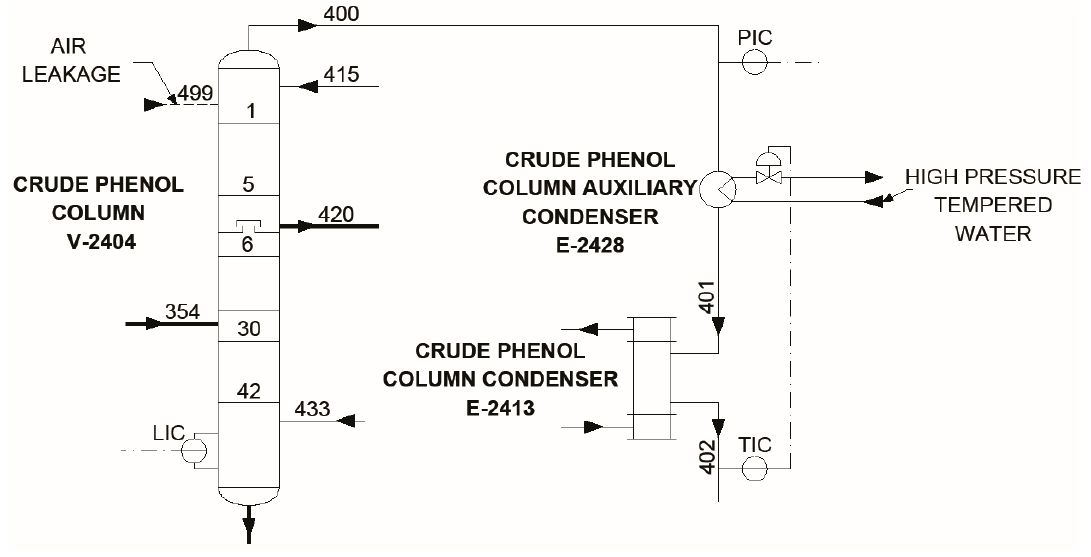
Figure 2. Process flow diagram of crude phenol column.